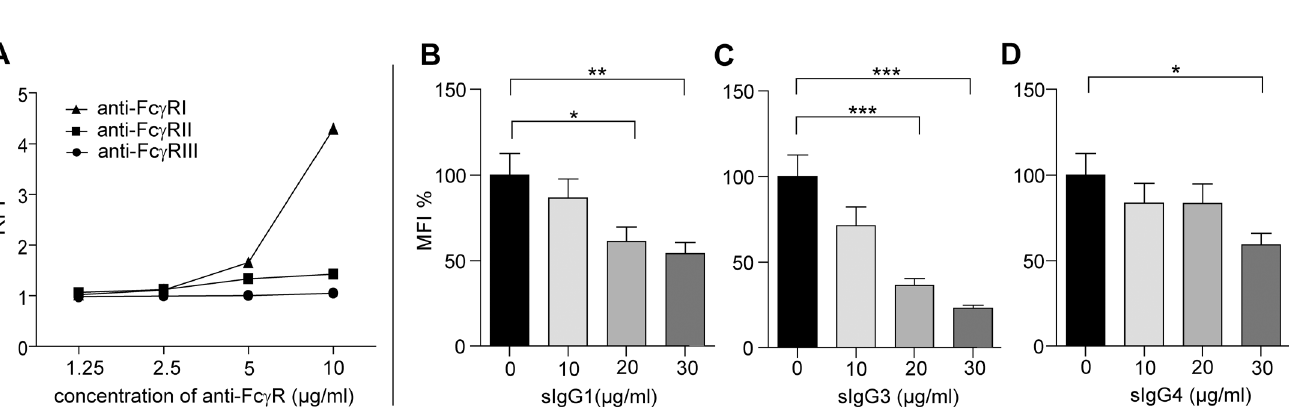
Fig 4. Activation of U937-NF- κ B cells occurs mainly through Fc γ RI. The U937-NF- κ B cells were activated on anti-Fc γ R-coated surfaces (A). Fc γ RI cross-linking induces strong, while Fc γ RII results in weaker activation. The cell activation was measured on IgG4-coated surfaces (B, C, D) in the presence of soluble IgG1(B), IgG3 (C) and IgG4 (D) in three doses (10, 20, 30 μ g/ml). The untreated cells on IgG4 coat served as control (black bars). Results are mean % ± SEM % (n = 9) * p < 0.05 versus control (untreated cells).